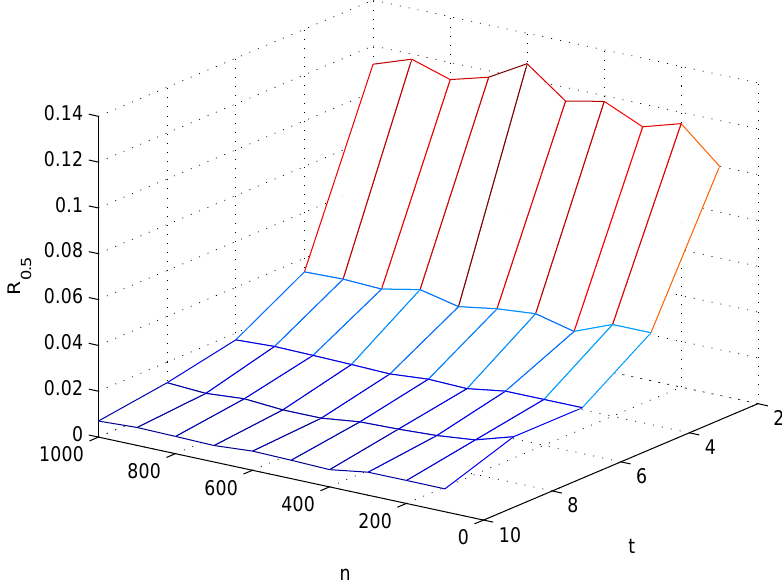
Figure 4. R ’s in different 0 . 5